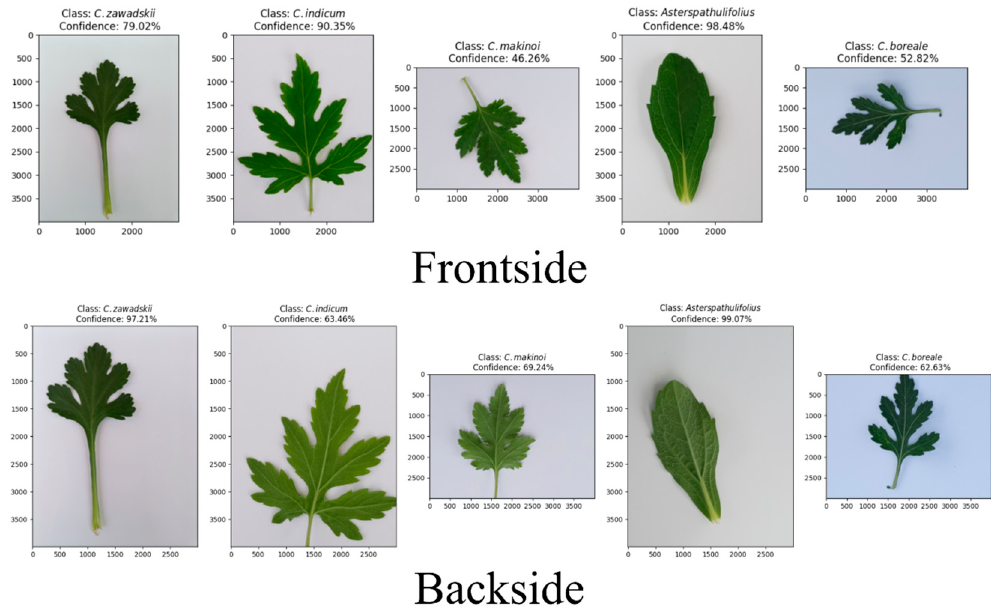
Figure 5. The model performance on frontside and backside of leaves of five wild chrysanthemums species found in Korea.